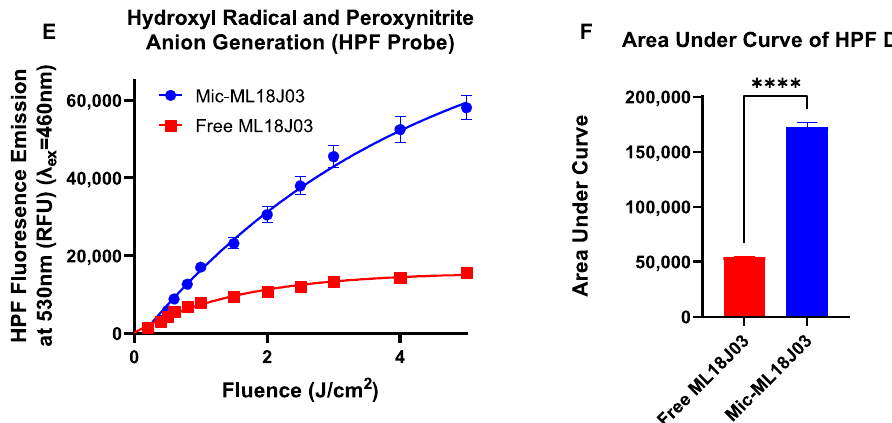
Figure 3. ( A , B ) Production of singlet oxygen by free ML18J03 and Mic-ML18J03 measured using the fluorescent probe Singlet Oxygen Sensor Green (SOSG; λ Exc = 460 nm, λ Emi = 530 nm). ( C , D ) Singlet oxygen generation by free ML18J03 and Mic-ML18J03 measured using the colorimetric probe anthracene dipropionic acid (ADPA) at 378 nm absorbance. ( E , F ) Hydroxyl radical and peroxynitrite generation by free ML18J03 and Mic-ML18J03 measured using the fluorescent probe hydroxyphenyl fluorescein (HPF). (All of the data is presented as mean ± standard error; statistical significance was calculated using a two-tailed t -test, **: p ≤ 0.01, ****: p ≤ 0.0001).